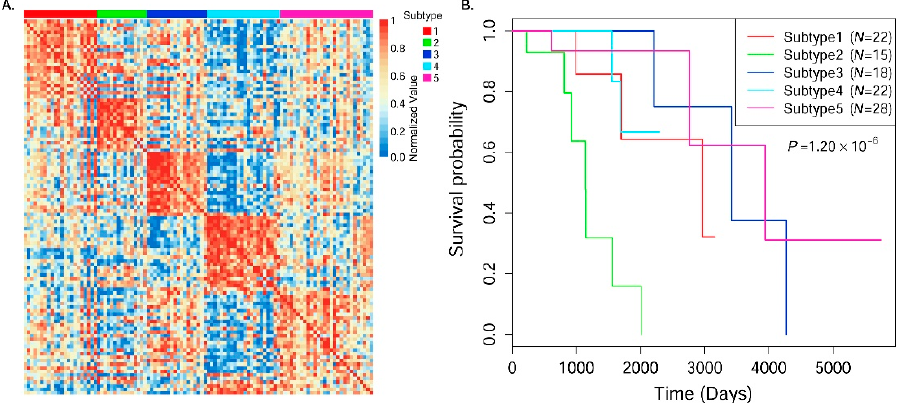
Figure 3. The identified subtypes in BIC cancer datasets. ( A ) Heatmap of the predicted integrative similarity matrix between samples (row normalized, arranging samples by predicted subtype labels); ( B ) Kaplan–Meier survival probability curves of patients in the identified subtype clusters. The Cox log-rank test p -value was